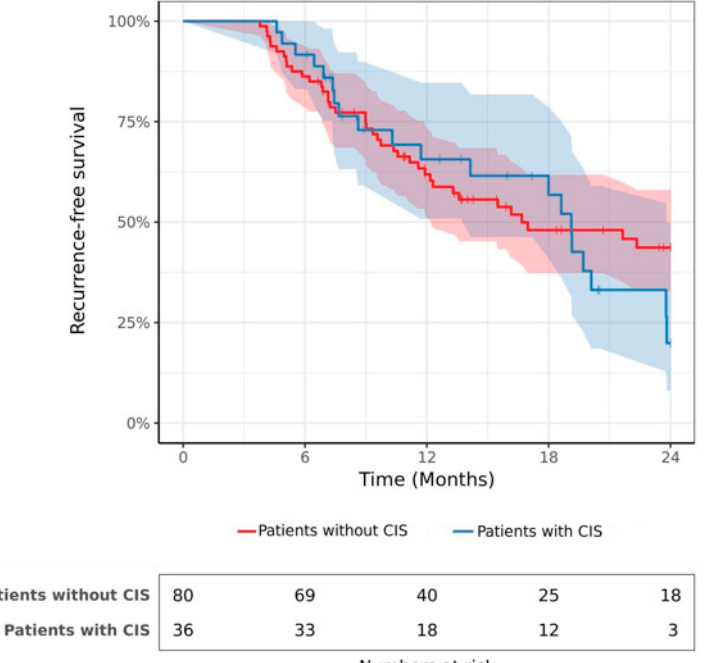
Table 2. No significant association was observed between CIS and the hazard of recurrence